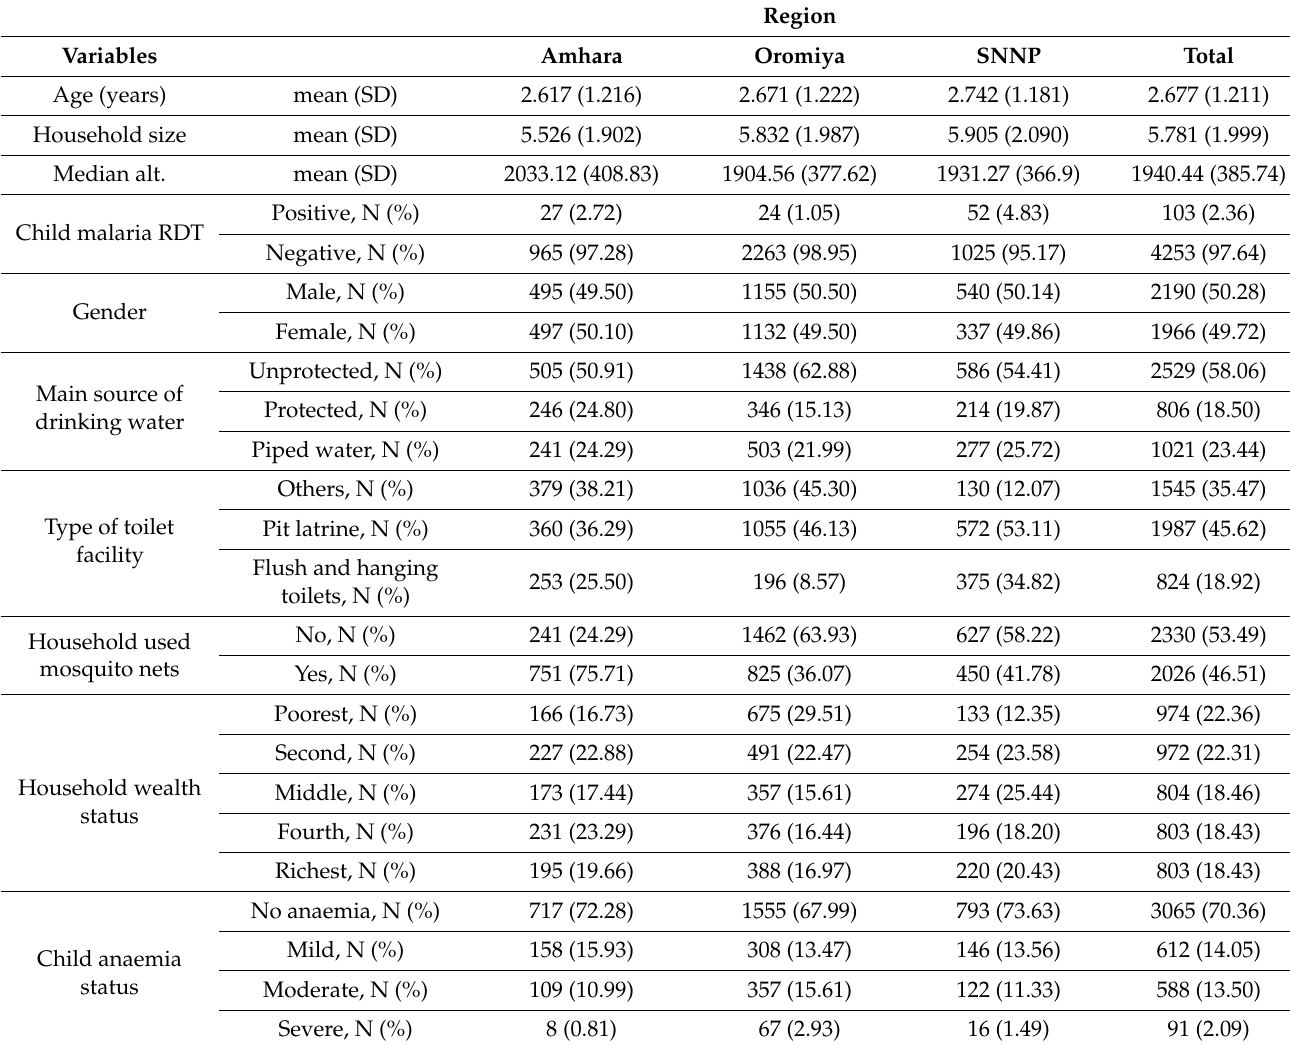
Table 1. Descriptive statistics for study